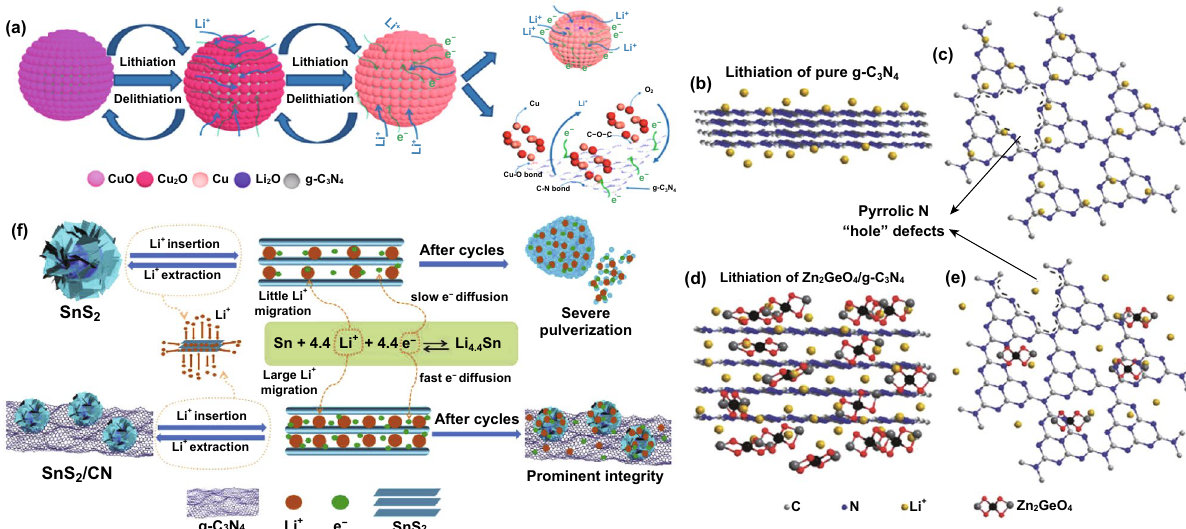
Fig. 18 a Schematic description explaining the reaction mechanism of the CuO/O-doped g-C 3 N 4 anode during the charge/discharge process. Reproduced with permission from Ref. [116]. Illustrations of pure ( b , c ) g-C 3 N 4 and ( d , e ) Zn 2 GeO 4 /g-C 3 N 4 hybrids for Li-insertion viewed from the ( b , c ) edge and ( d , e ) basal plan directions. Reproduced with permission from Ref. [111]. f Schematic illustration of the Li-ions diffu- sion and electronic transport in the SnS 2 and SnS 2 /CN composite electrode during the charge/discharge processes. Reproduced with permission from Ref. [117]. Copyright permissions from Elsevier, Royal Society of Chemistry, American Chemical Society and Wiley–VCH. (Color figure